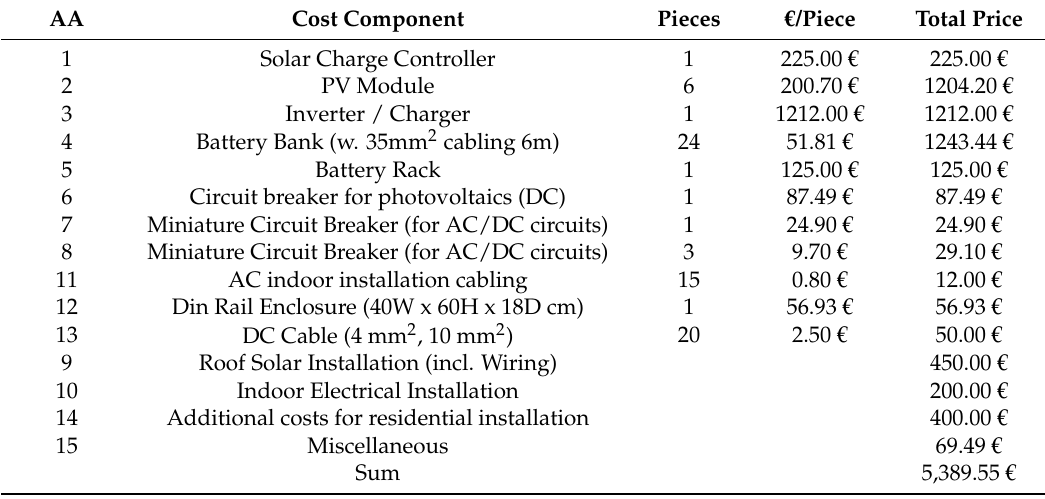
Table 1. Capital cost components.